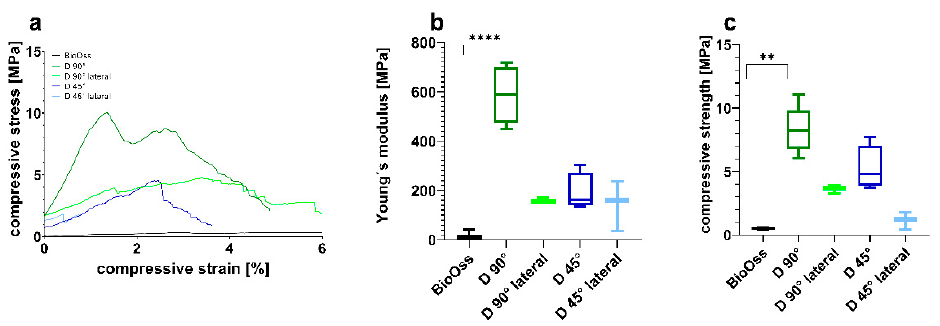
Figure 7. Mechanical properties of CPC scaffolds with different strand orientations in comparison with BioOss ® . ( a ) Representative compressive stress–strain curves. ( b ) Young’s modulus and ( c ) compressive strength determined from the curves (* p ≤ 0.05, ** p ≤ 0.01, *** p ≤ 0.001, **** p ≤ 0.0001, mean ± standard deviation, n = 5).